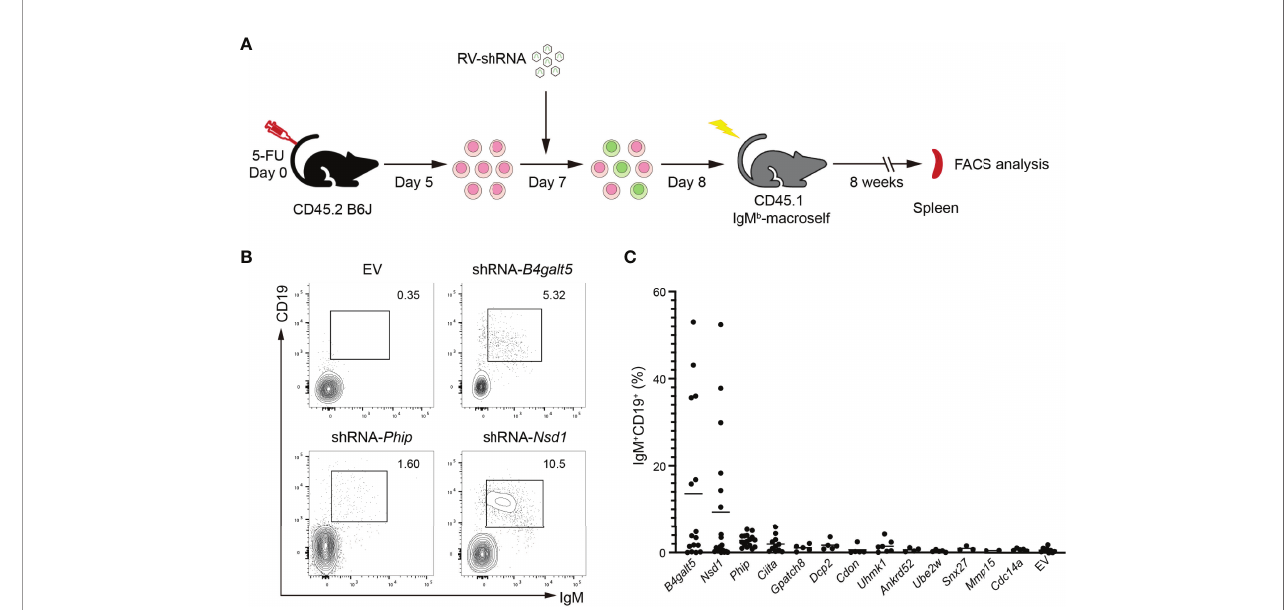
FIGURE 4 | In vivo validation of positive hits in IgM b -macroself mice. (A) Experimental outline of the in vivo validation strategy. HPSCs were enriched from 5-FU- treated C57BL/6J, transduced with retroviruses encoding individual shRNAs or empty vector (EV), and used to reconstitute sublethally irradiated IgM b -macroself mice. After 8 weeks, the presence of splenic B cells was analyzed in these mice by fl ow cytometry to determine a potential break of B cell tolerance. (B) Representative fl ow cytometry plots of splenocytes from IgM b -macroself recipient mice reconstituted with donor HSPCs transduced with retrovirus encoding the ‘ top hit ’ shRNAs ( B4galt5 and Nsd1 ) or no shRNA (EV, empty vector) at terminal analysis. Numbers adjacent to outlined areas indicate percentage of IgM + CD19 + cells (B cells) among splenocytes. (C) Graph summarizing percentages of IgM + CD19 + splenic B cells in IgM b -macroself mouse model reconstituted with HPSCs transduced with top hit shRNAs. Each dot indicates an individual mouse, and the horizontal lines indicate the mean value of mice analyzed for each group with n=16 for B4galt5 , n=19 for Nsd1 , n=16 for Phip , n=11 for Ciita , n=7 for Uhmk1 , n=5 for Gpatch8 , Dcp2 , Cdon , Ube2w and Cdc14a , n=4 for Ankrd52 , n=3 for Snx27 , n=2 for Mmp15 , and n=9 for EV. No statistically signi fi cant differences were